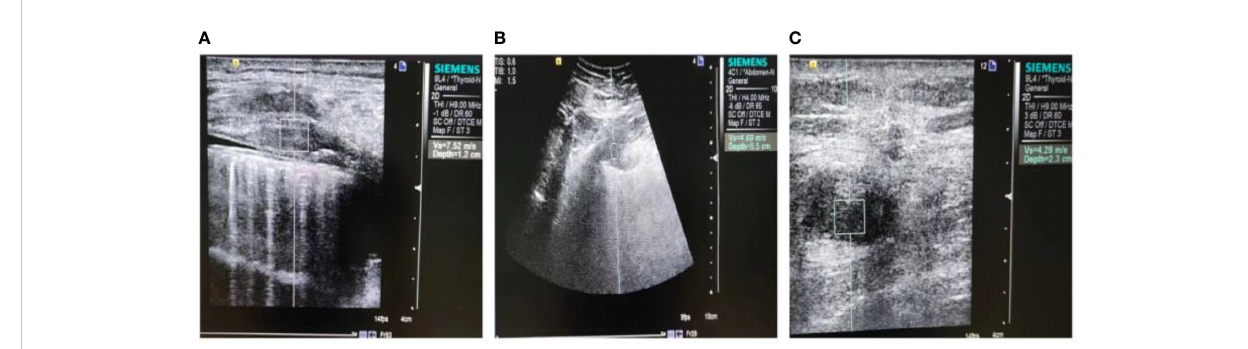
FIGURE 2 Ultrasound images of malignant chest wall and peripheral non-small cell lung cancers. (A) A solid hypoechoic nodule is displayed, with poorly de fi ned borders and an irregular shape. The measurement depth is 1.2 cm and the VTQ value is 7.52 m/s. (B) A heterogeneous hypoechoic mass is shown, with unclear boundaries and an irregular shape. The measurement depth is 5.5 cm and the VTQ value is 4.69 m/s. (C) Another heterogeneous hypoechoic mass is displayed, with unclear borders, an irregular shape, and a burr-like appearance. The measurement depth is 2.3 cm and the VTQ value is 4.29